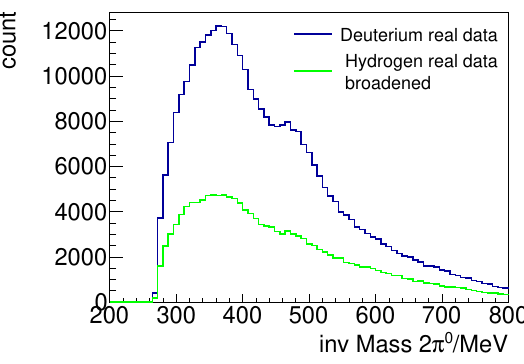
Figure 6. 2 π 0 invariant mass spectrum for deuterium data and broadened and scaled hydrogen data. The hydrogen data make up about half of the deuterium